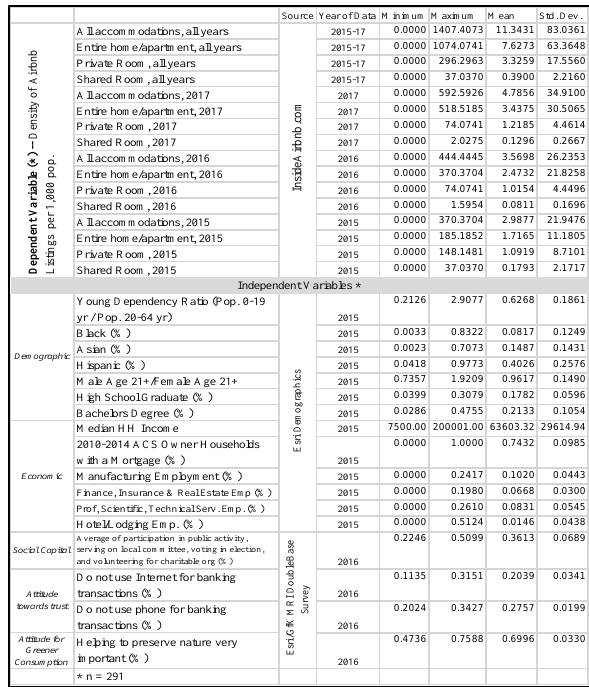
Table 1. Descriptive Statistics of